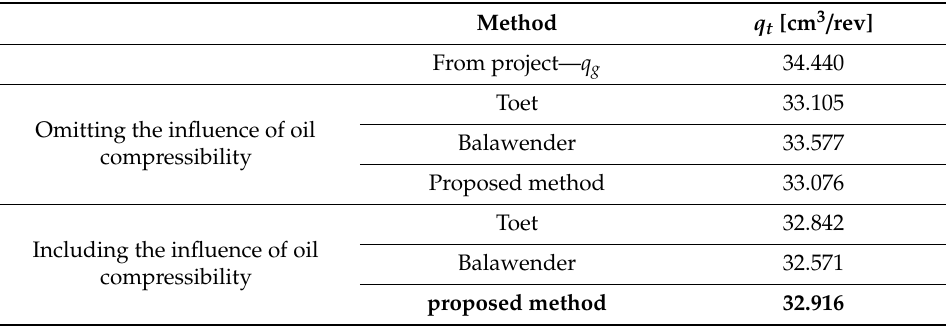
Table 1. Theoretical working volume q t of a satellie motor.